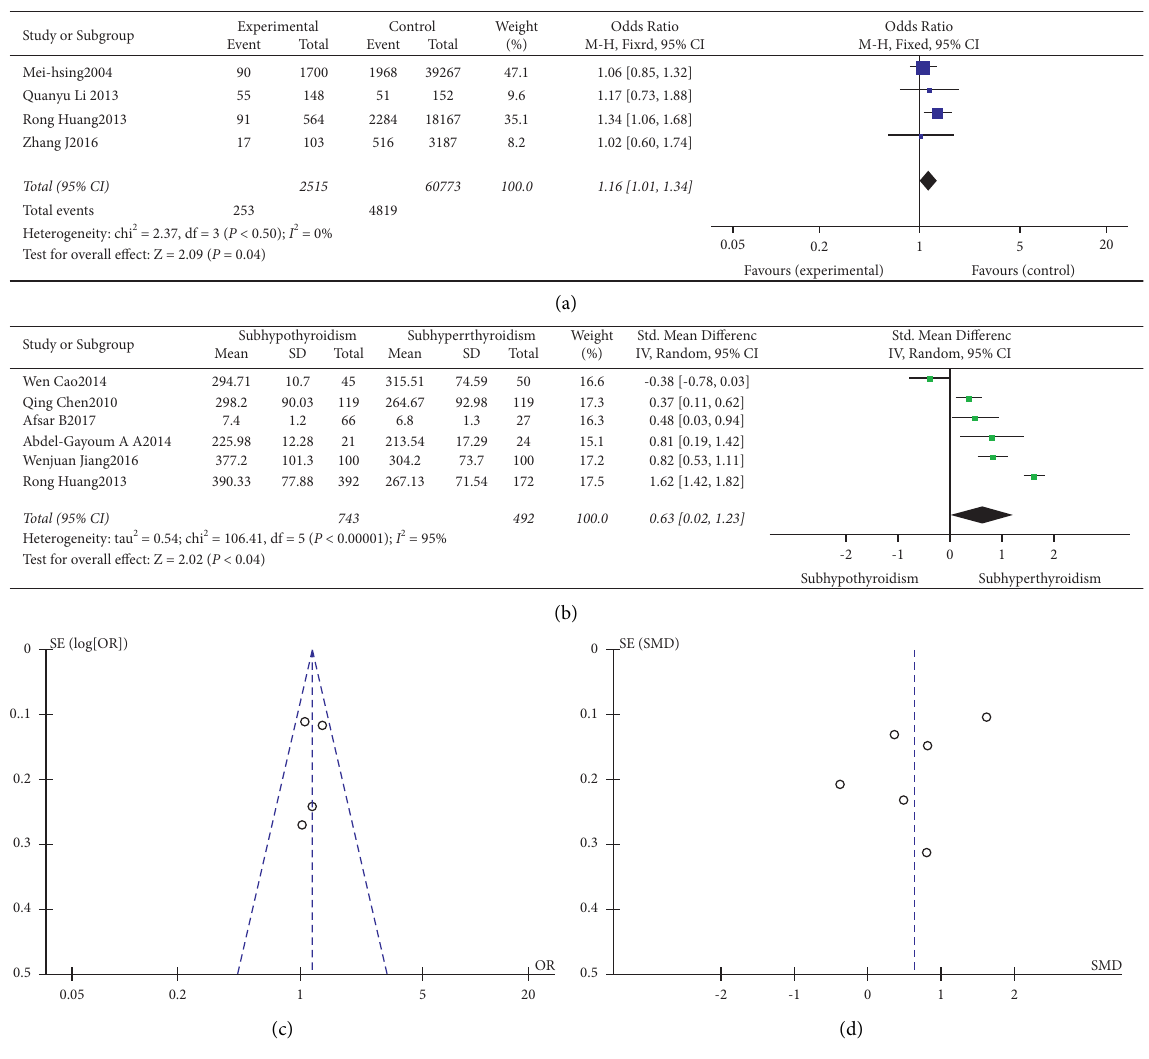
Figure 2: (a) Forest plot of subclinical thyroid dysfunction and hyperuricemia. (b) Forest plot of the comparison of subclinical hypo- thyroidism and subclinical hyperthyroidism. (c) Funnel plot of subclinical thyroid dysfunction and hyperuricemia. (d) Funnel plot of the comparison of subclinical hypothyroidism and subclinical